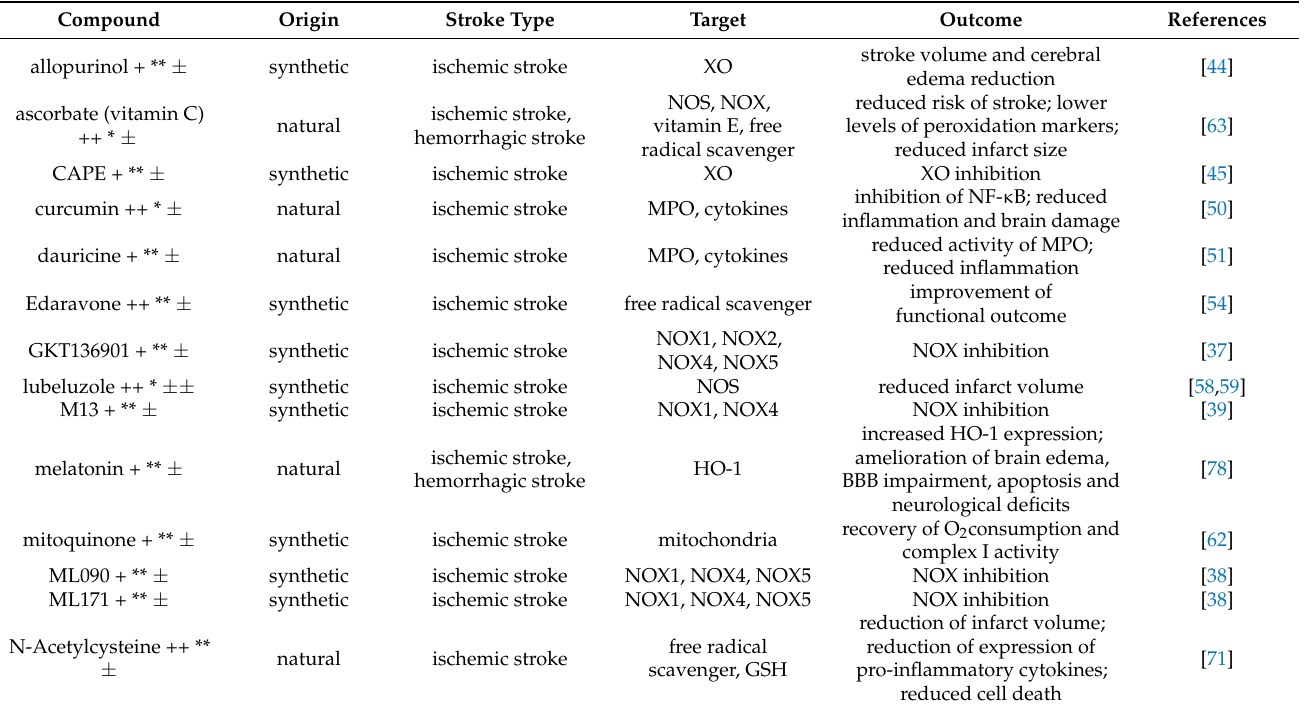
Table 1. A list of compounds used in antioxidant stroke treatment that were discussed in the